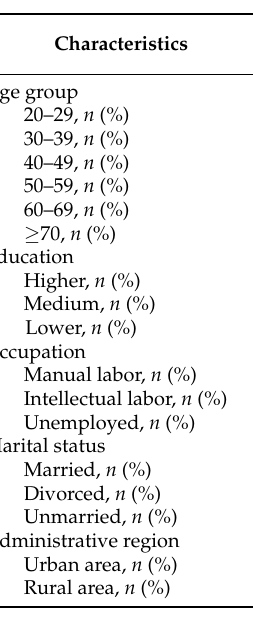
Table 1. Demographic and social characteristics of the study